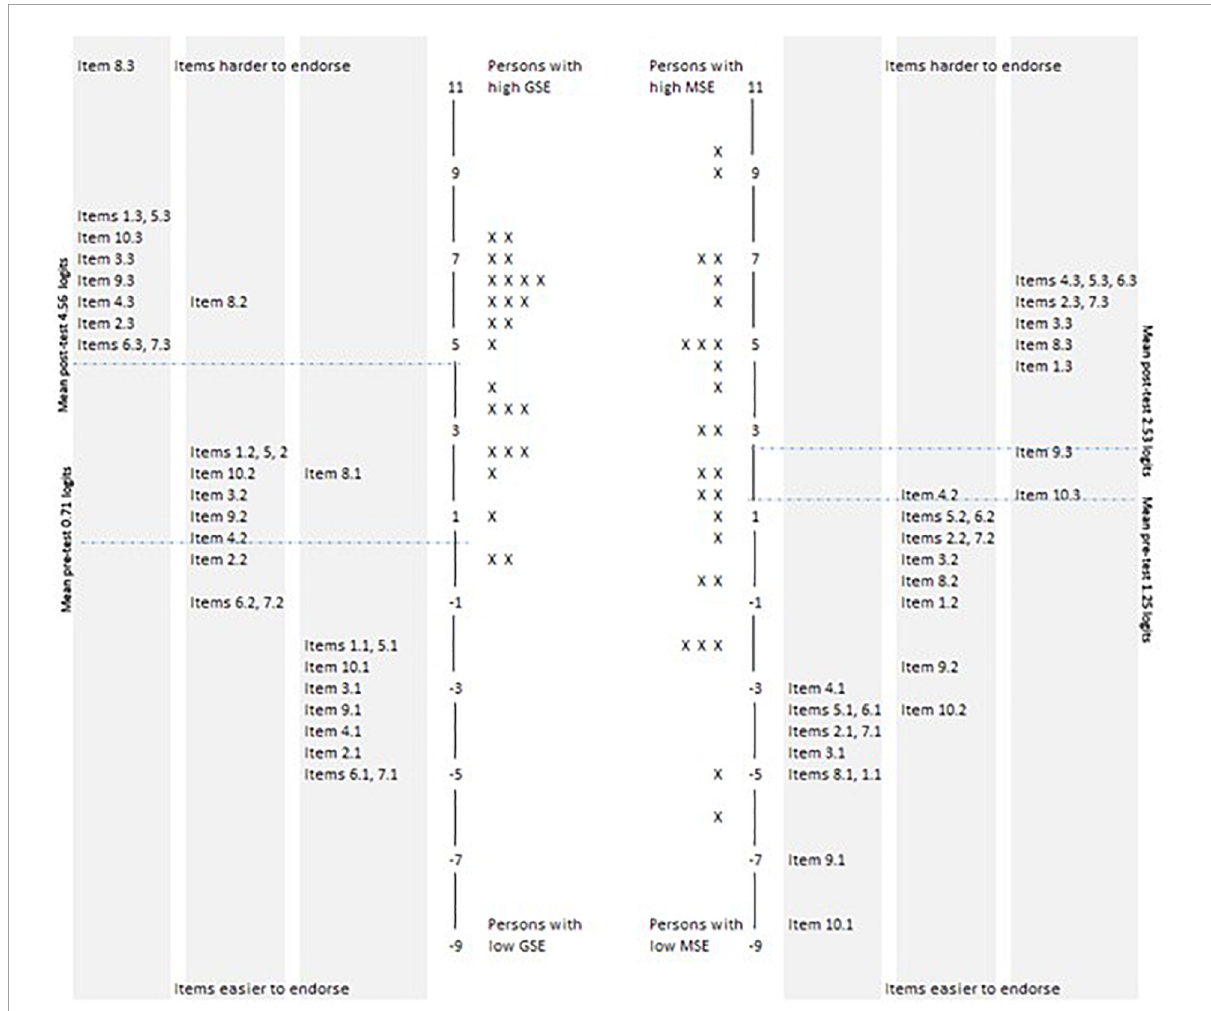
FIGURE2 Wright maps for post-test GSE (to the left) and post-test MSE (to the right) results.